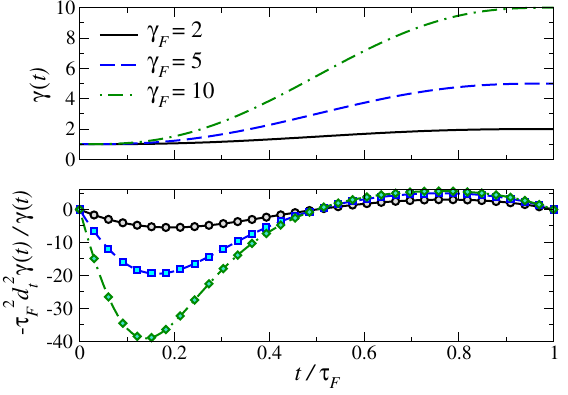
FIG. 3. Shortcut to an adiabatic expansion by local counter- diabatic driving. Whenever the trapping potential U ð q ; t Þ ¼ U 0 ½ q = γ ð t Þ(cid:1) = γ ð t Þ 2 [with f ð t Þ ¼ 0 ], the auxiliary counterdiabatic term modulated by − m ̈ γ = γ ð t Þ induces a nonadiabatic self-similar dynamics that reduces to the target state Ψ ð t Þ at t ¼ f 0 ; τ when the auxiliary term vanishes. This protocol holds exactly for an arbitrary trapping potential U 0 ð q Þ and can be applied to an arbitrary single-particle, nonlinear, or many-body system. In the case of interacting systems, it requires a modulation of the coupling constant ϵ ð t Þ , as in Eq.